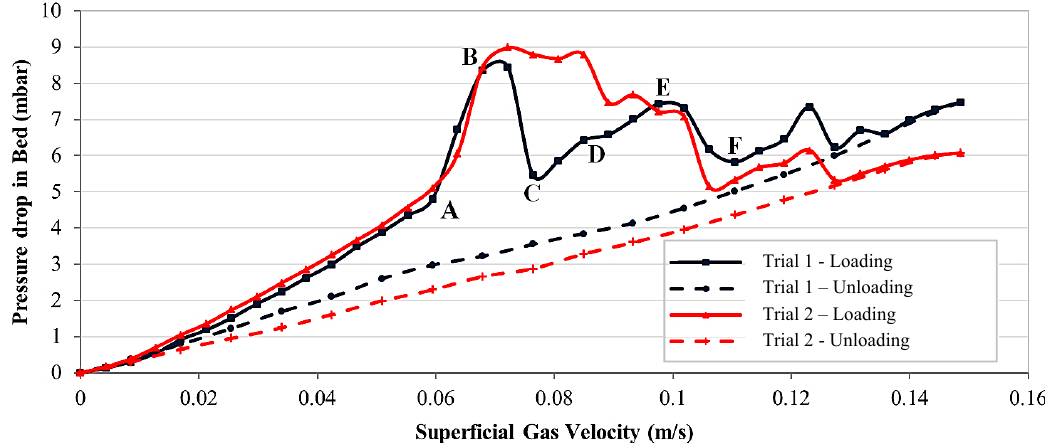
Figure 5. Two independent fluidization tests—Loading (—) and Unloading ( − − ) of ultra-fine powder bed (CALCIT MX-10).